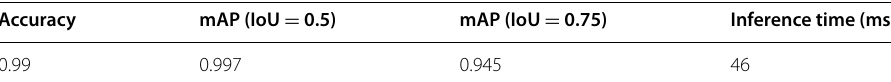
Table 1 Pattern recognition